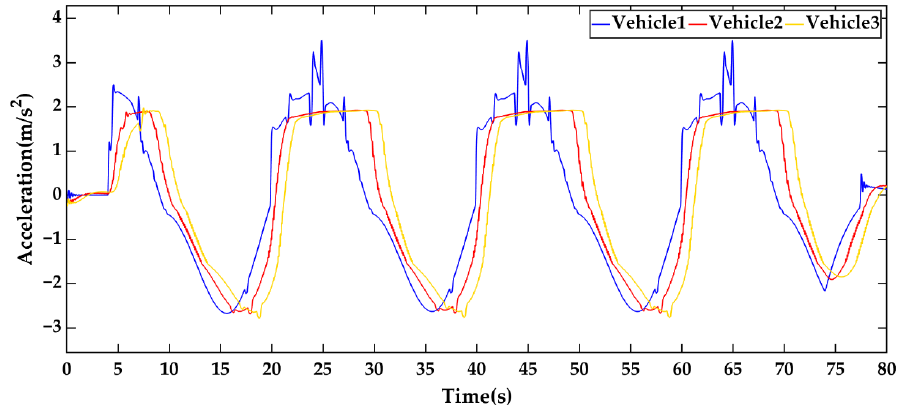
Figure 20. The accelerations of the following vehicle under the improved MPC strategy in Scenario 2.